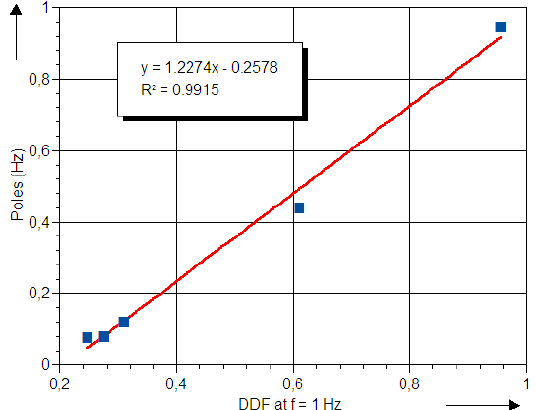
Figure 11. Correlation between the DDF at f = 1 Hz and the